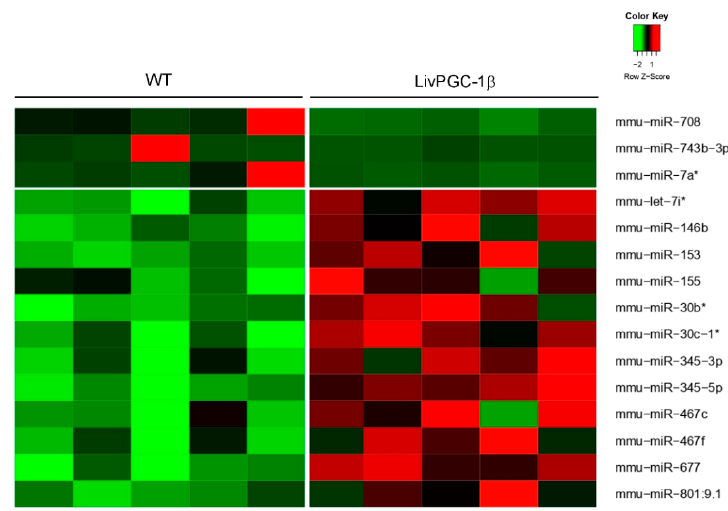
Figure 2. Microarray analysis of hepatic microRNAs in mice overexpressing PGC-1 β in the liver compare to wild type control. The data are shown in a heatmap with a matrix format; each single row represents the expression of one microRNA in a single liver sample harvested from overnight fasted LivPGC-1 β mice or WT controls (column). To visualize the results, the expression levels of each gene are represented by a color (red: expression greater than the mean; black: expression equal to the mean; green: expression smaller than the mean). The * is used to distinguish mature microRNA that, differently from the dominant-highly expressed microRNA, originates from the opposite arm of the hairpin precursor.